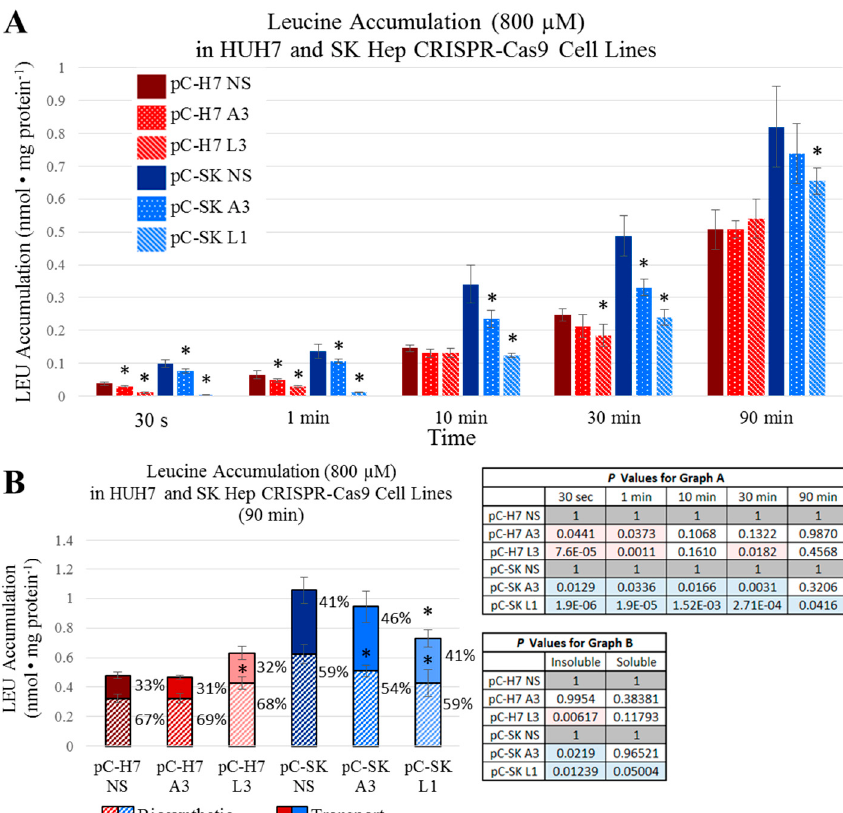
Figure 7. Intracellular leucine ( L -[ 3 H]Leu) accumulation over time. Accumulation of 800 µ M L -leucine was measured as described in Materials and Methods. ( A ) Intracellular accumulation of leucine was measured in ASCT2- and LAT1-targeted HUH7 cell lines (pC-H7 A3 and L3, respectively) in comparison to the nonsilencing control cell line (pC-H7 NS), and in ASCT2- and LAT1-targeted SK Hep cell lines (pC-SK A3 and L1, respectively) in comparison to the nonsilencing control cell line (pC-SK NS); ( B ) Intracellular fractions of free and biosynthetically incorporated radioactive L -leucine were measured after 90 minutes of accumulation as described in Materials and Methods. Data are the average of at least four separate determinations ± SD. Asterisks (*) denote values statistically significant at p < 0.050 vs. NS control; actual p values are shown in the adjacent tables with pink or blue shaded values indicating p < 0.050.